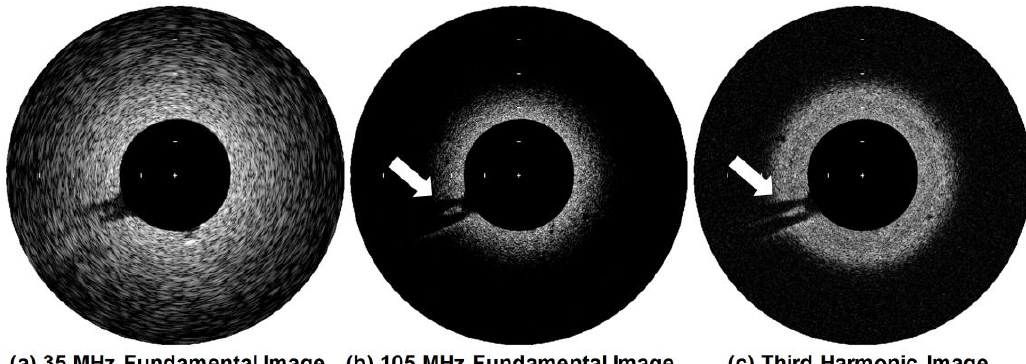
Figure 12. Ultrasound fundamental images of the tissue-mimicking phantom acquired by the ( a ) 35-MHz element and ( b ) 105-MHz element. ( c ) The third harmonic image was constructed using the image data acquired after transmitting ultrasound by the 35-MHz element and subsequently receiving the third harmonic signals generated in the phantom by using the 105-MHz element. The white arrows indicate the lesion-mimicking area. Logarithmic compression with a dynamic range of 30 dB was performed. The space between the white bars on the images indicates 1 mm.